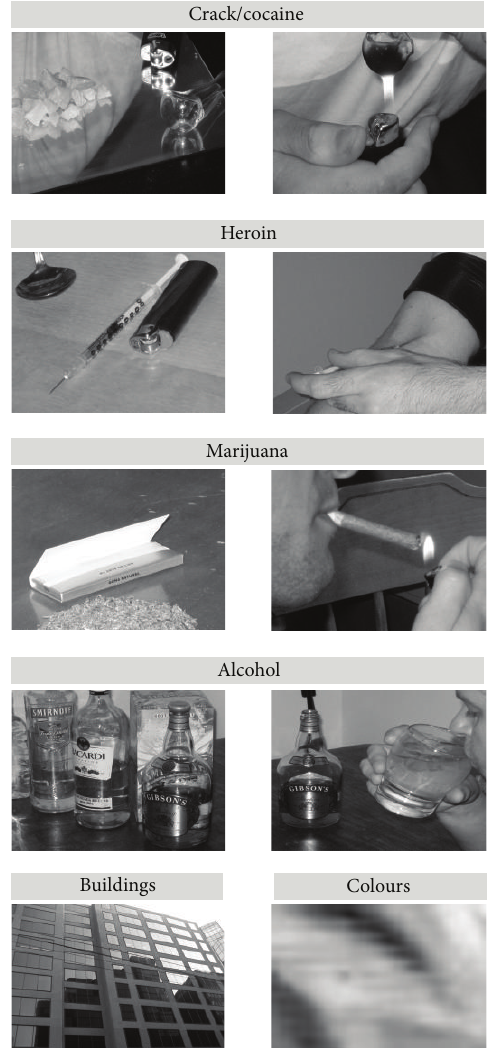
Figure 1: Examples of images (in black and white) employed in the CRT